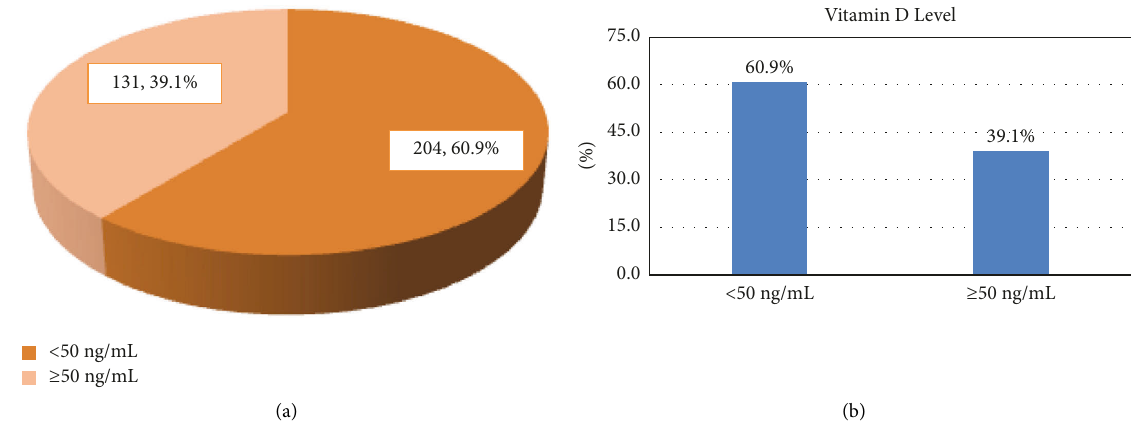
Figure 2: (a): Vitamin D level among the participants. (b): Vitamin D level among the